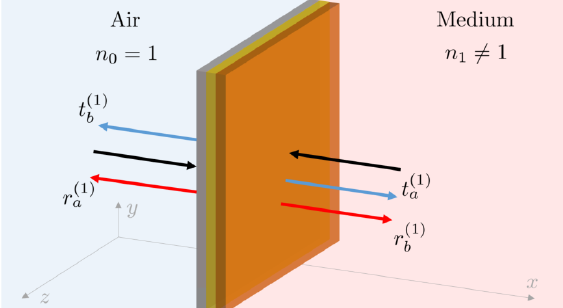
Figure 4. Schematic view of an asymmetric mirror interface with coherent light absorption. The mirror consists of a reflecting layer which may be covered on both sides by thin layers of absorbing material. On the right-hand side, it is attached to a dielectric medium with a refractive index n 1 (cid:54) = 1. On the left, the mirror interface borders on air with a refractive index n 0 = 1. Since light approaching the mirror from different sides might experience different absorption rates, the overall reflection and transmission rates of the mirror interface, r when referring to the case with the mirror being placed in